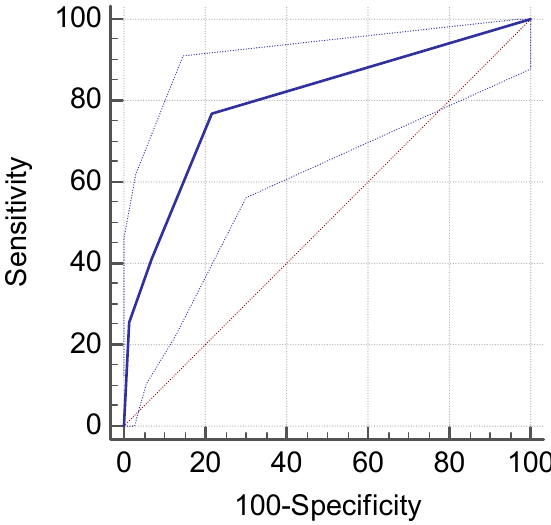
Figure 1. Performance of endoscopy in H. pylori infection detection.